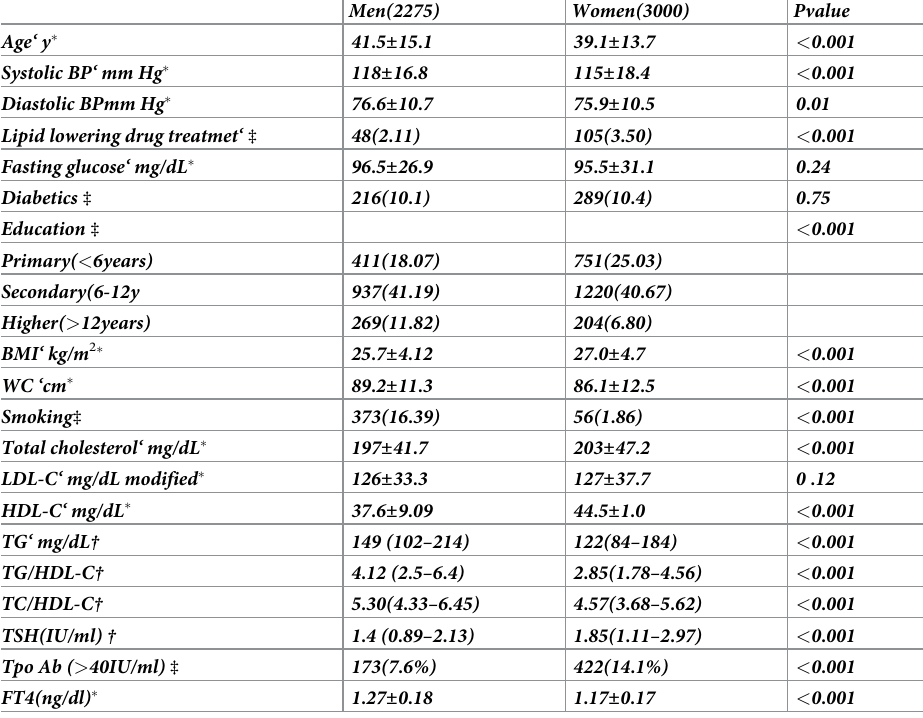
Table 1. Baseline characteristics of men and women